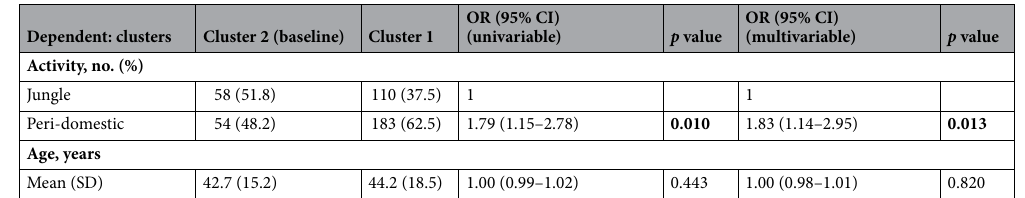
Table 2. Association of P. knowlesi clusters with activities and age in P. knowlesi patients (N = 405). p < 0.05 in bold.